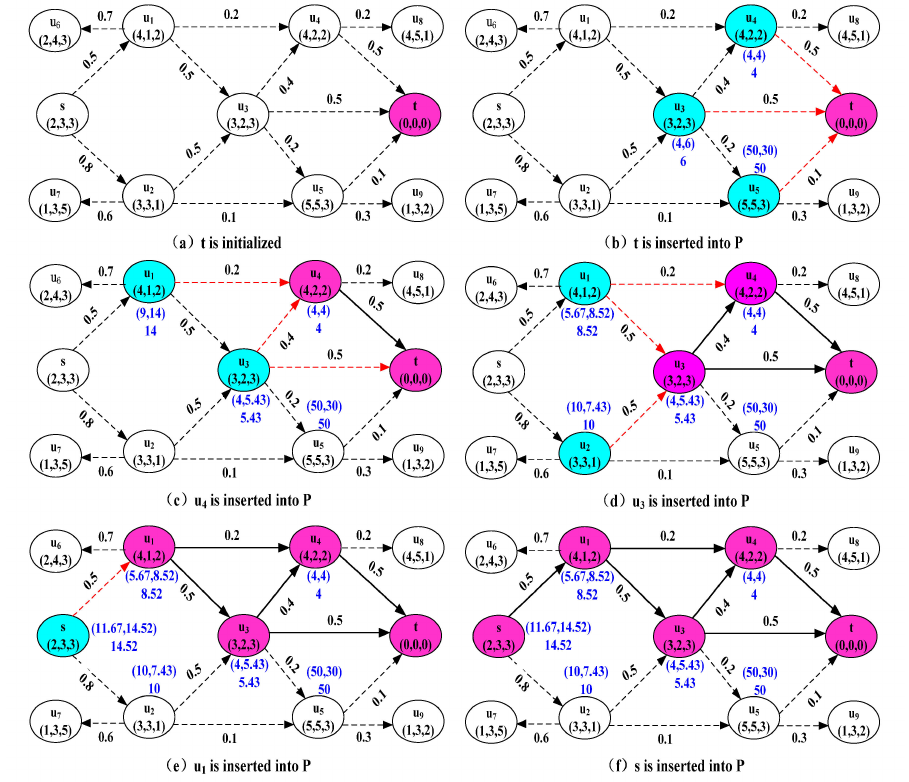
Figure 1. An example of the anypath computed by HMAA